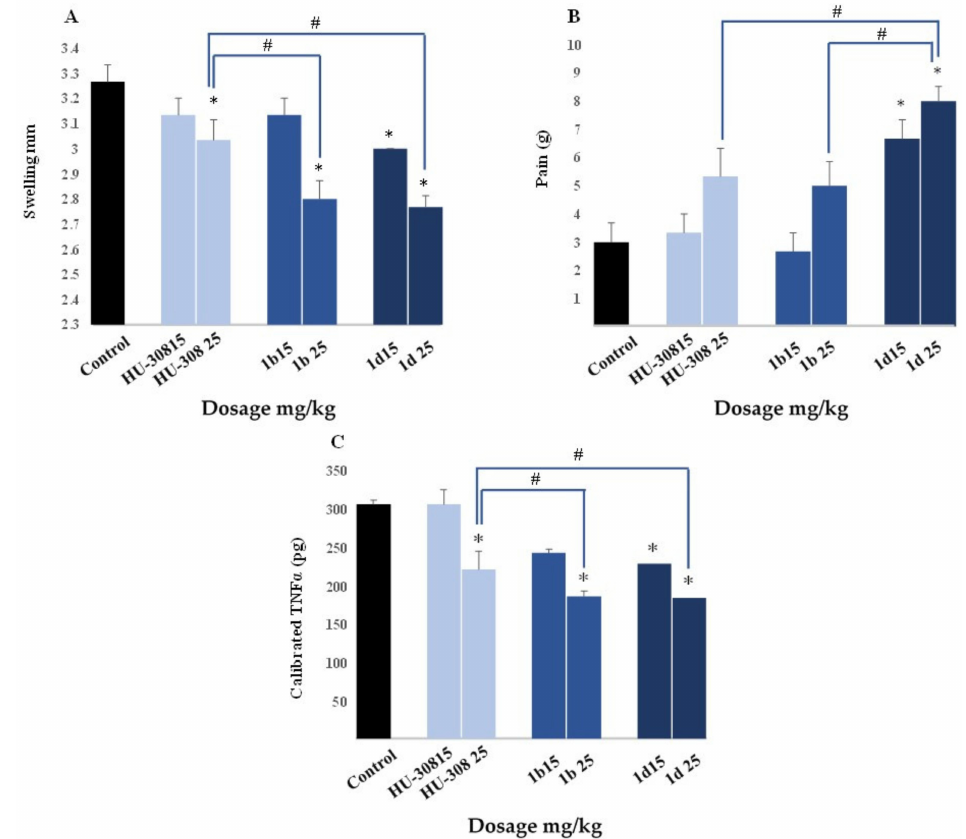
Figure 6. Anti-inflammatory and analgesic evaluation of HU-308 (light blue) compared to 1b (blue), 1d (dark blue) and vehicle control (black). ( A ) Swelling after six hours, ( B ) pain sensa- tion after six hours, and ( C ) TNF- α serum levels after 24 hours. Statistical comparison was done by 1-way ANOVA ( p -value = 0.05). * p < 0.05 comparing to control group. # p -value < 0.05 in the indicated